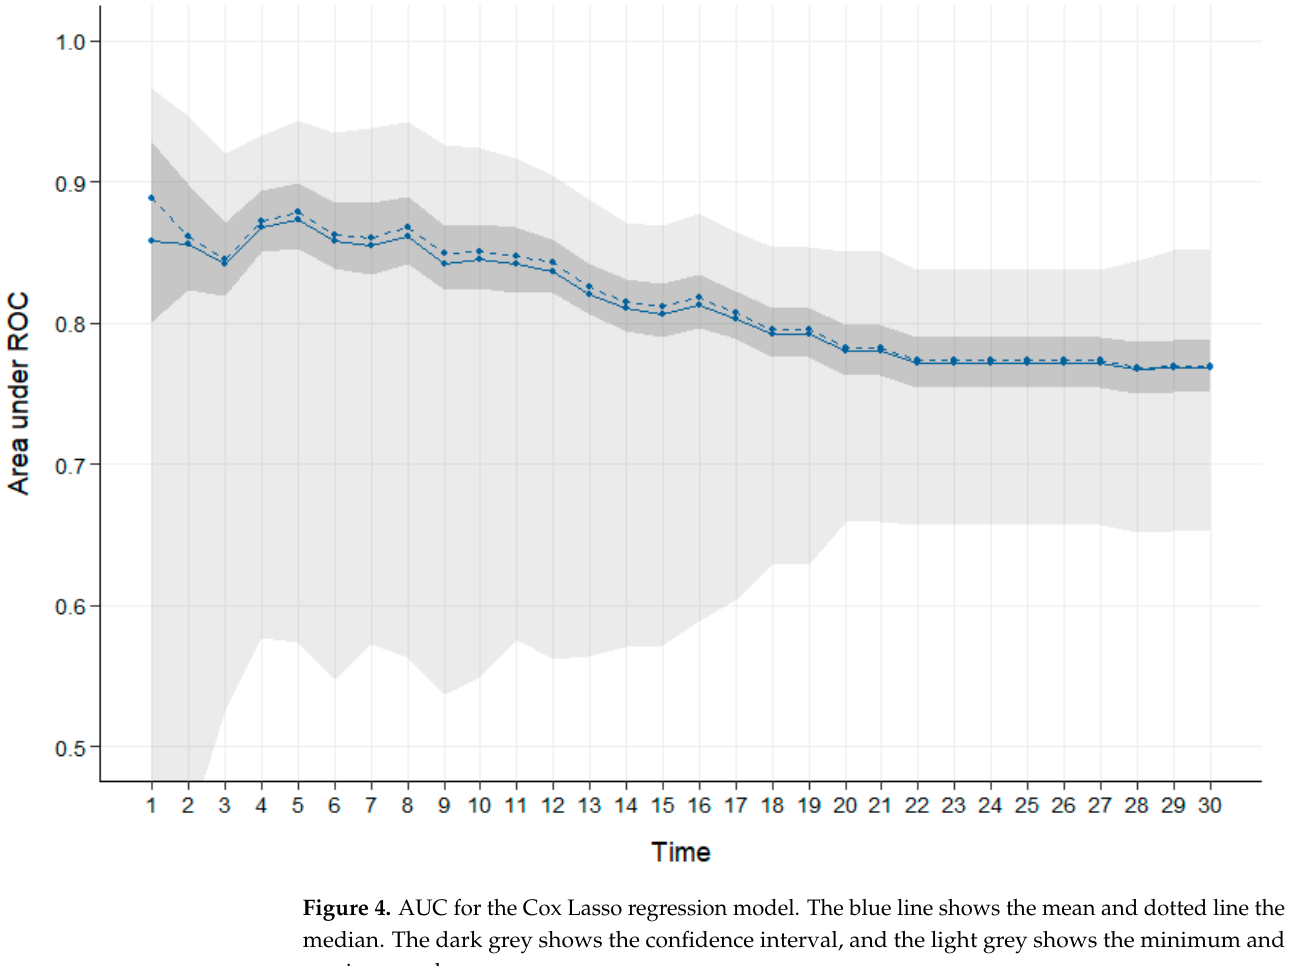
Figure 3. Kaplan–Meier survival curves using the Cox Lasso regression model. It shows three groupings based on prediction of 21-day risk, representing high, medium and low risk of dying.